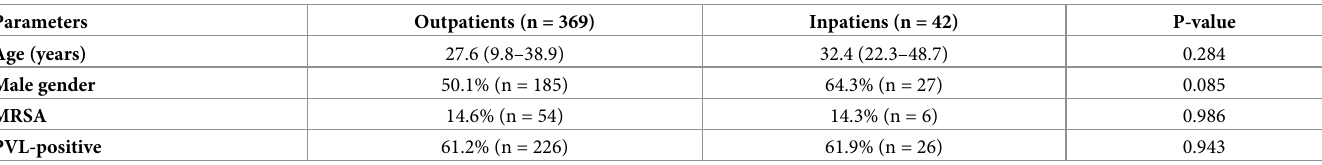
Table 1. Comparison of basic epidemiological parameters for inpatients and outpatients.